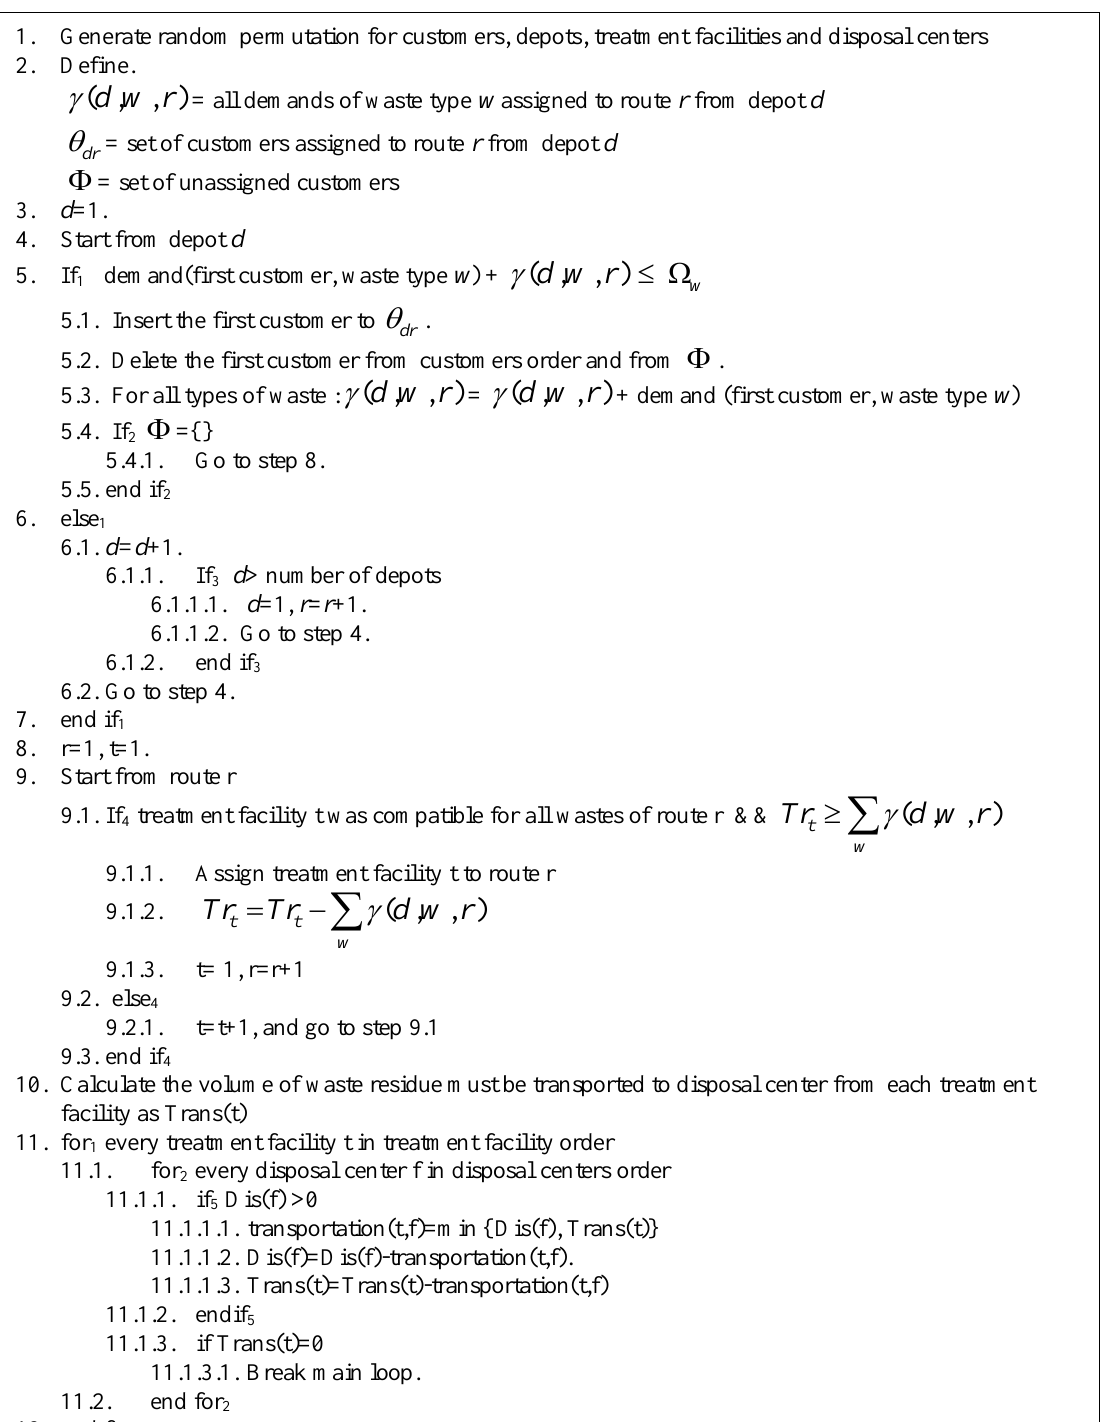
Fig 4 . Pseudo code of the construction